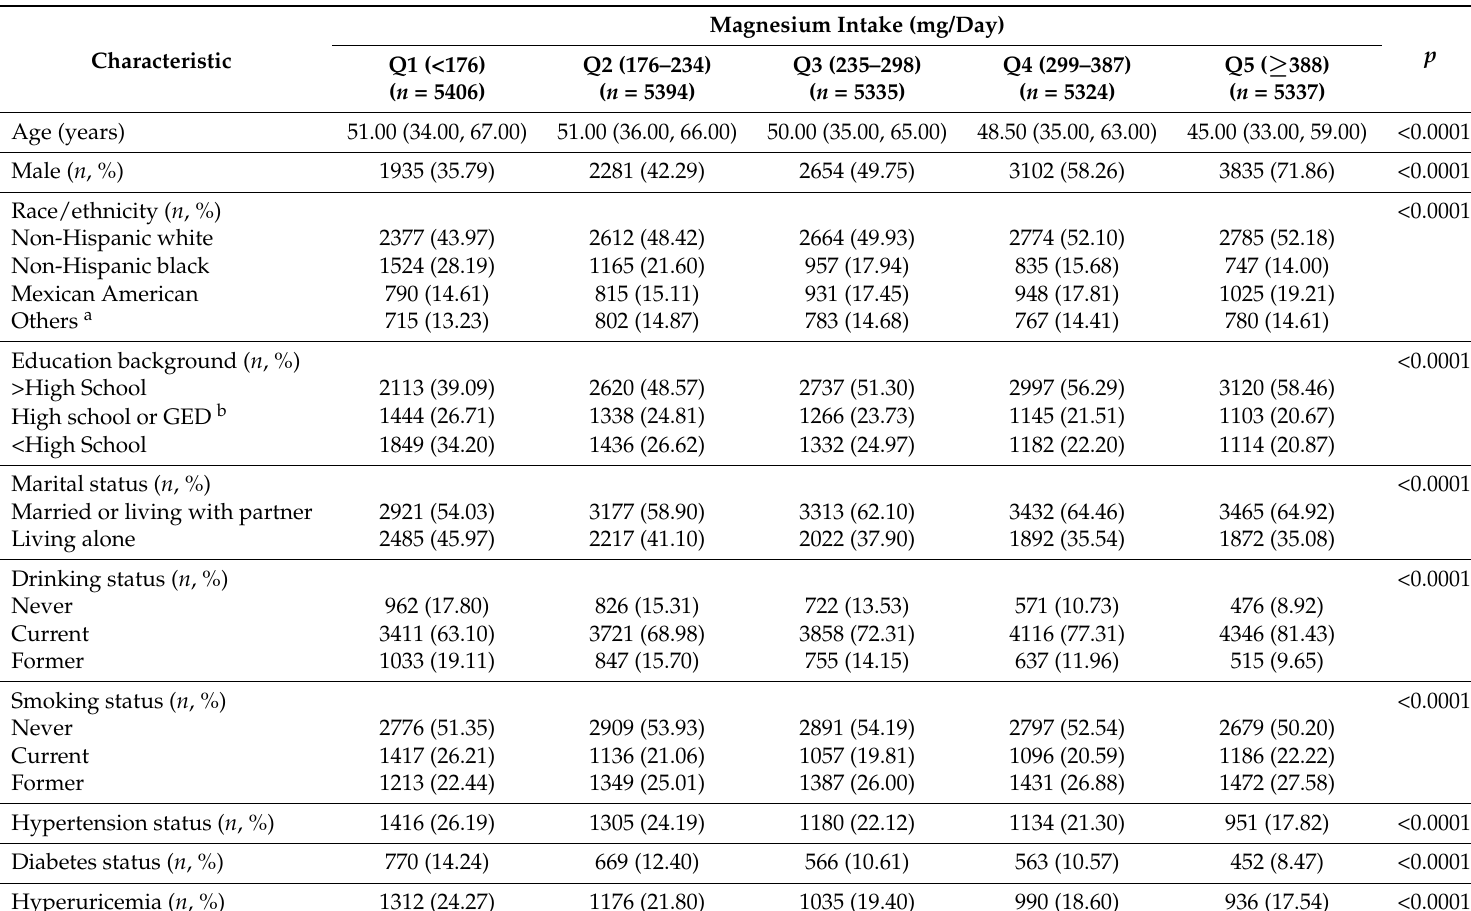
Table 3. Characteristics of the participants according to intake of